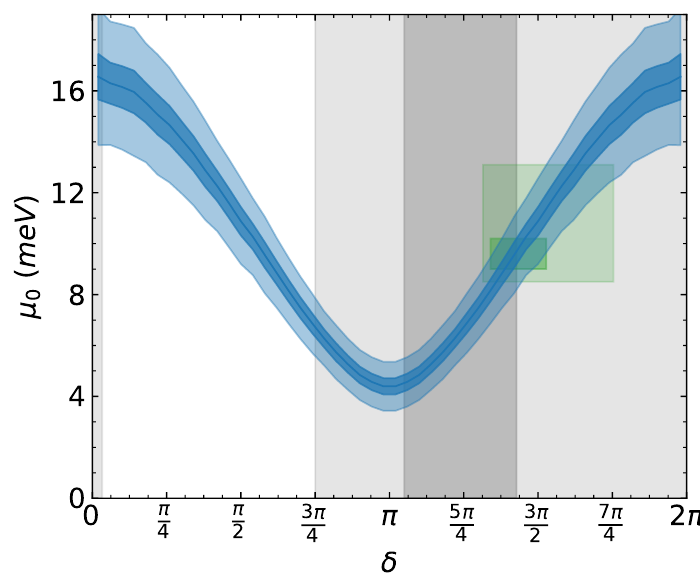
Figure 2 . Functional dependence of (cid:22) 0 vs. (cid:14) at the C 0 = 0 absolute minimum. The dark (light) gray area corresponds to the 1 (cid:27) (3 (cid:27) ) experimentally allowed region for (cid:14) from ref. [26]. The dark (light) green area encloses the values of (cid:14) and (cid:22) 0 for which the corresponding values of (cid:18) 23 (see the two plots in (cid:12)gure 1) remain within the 1 (cid:27) (3 (cid:27) ) experimental